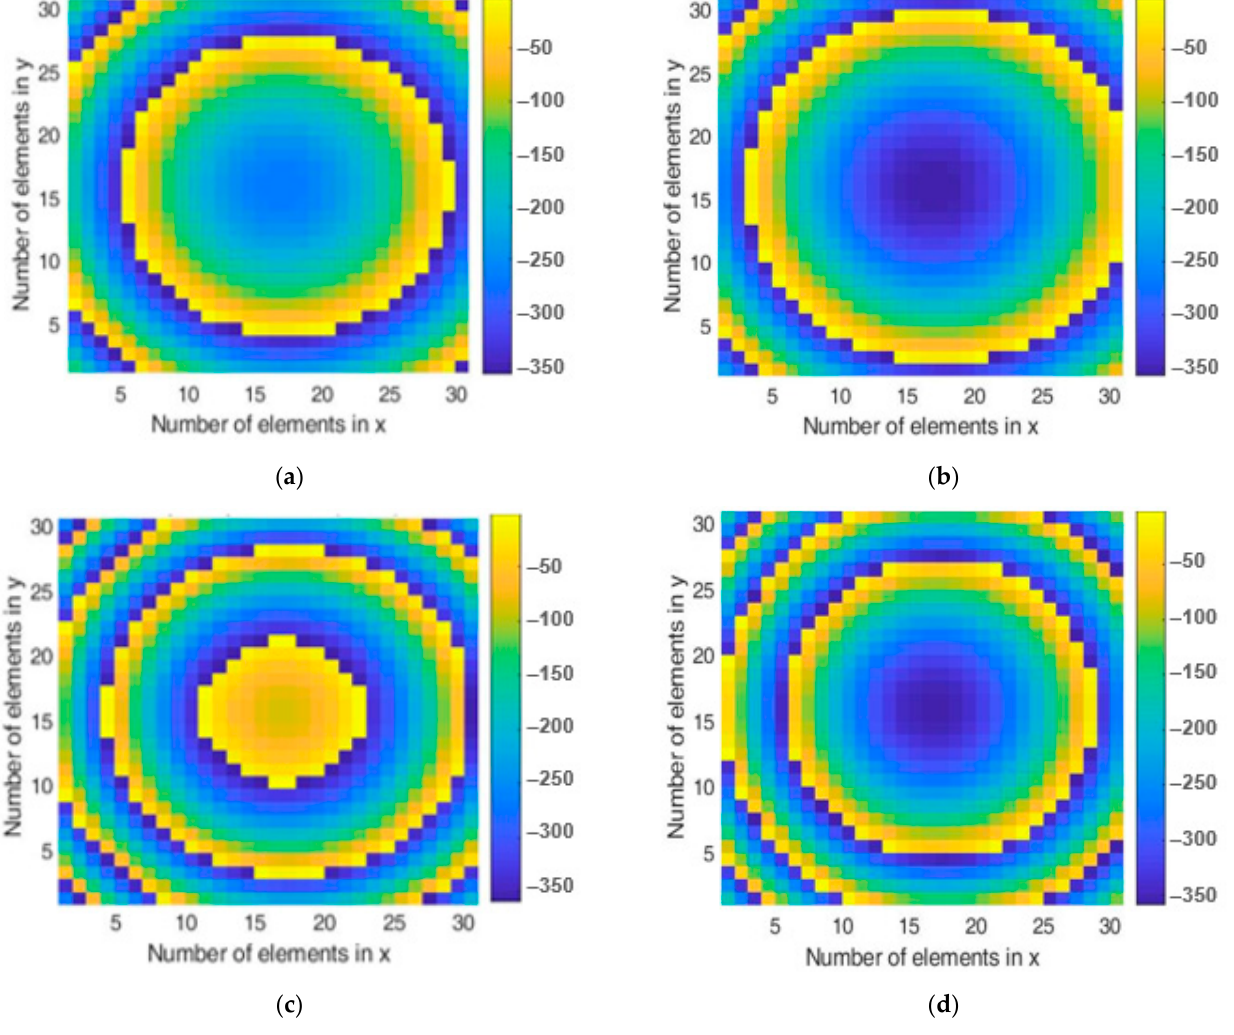
Figure 12. Phase shifts (in degrees) that must be introduced by the elements of the dual-band polarizer reflectarray in each component of the incident field: ( a ) x component at 19.7 GHz, ( b ) y component at 19.7 GHz, ( c ) x component at 29.5 GHz, and ( d ) y component at 29.5 GHz.